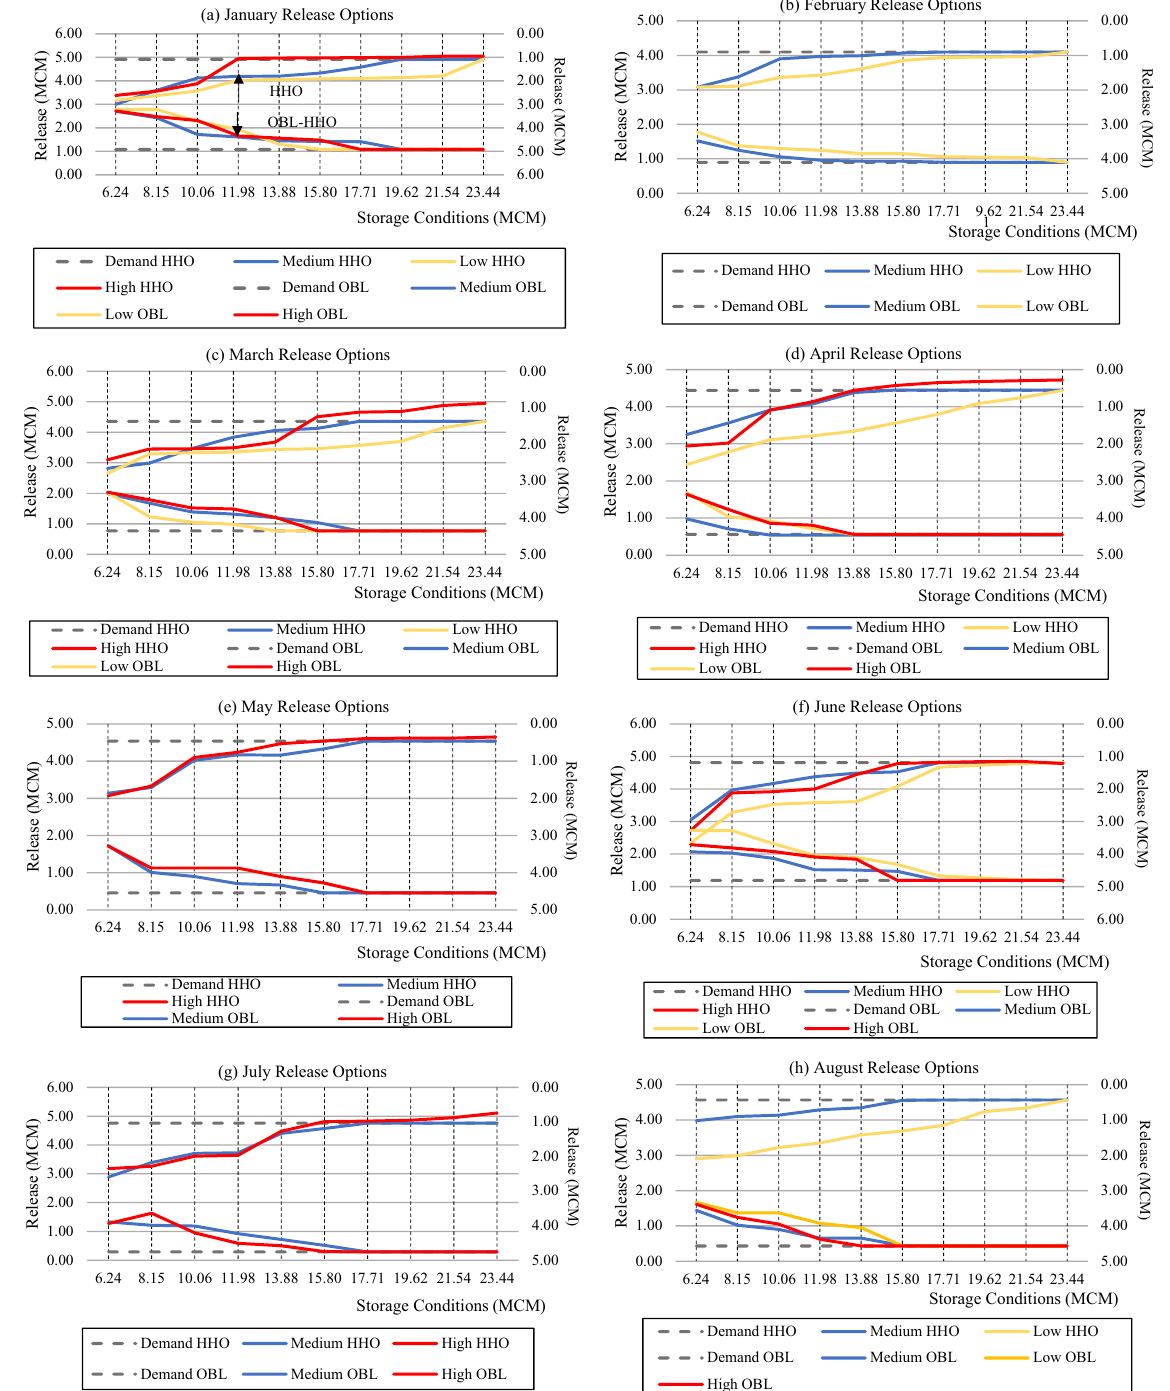
Figure 5. ( a )–( l ) Optimal policies of release between year 2001 to 2019 from January to December between HHO and OBL3.1.3Performance Evaluation in Terms of Reliability and Risk